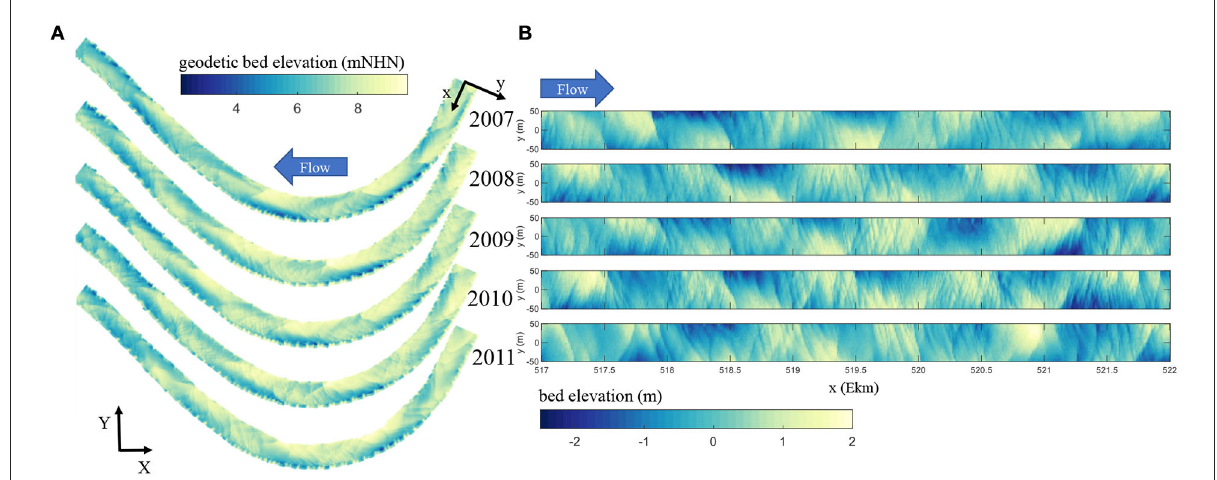
FIGURE5 Bed elevation data from 2007 to 2011 in AB2 (A) plotted in original geodetic coordinates and (B) cut and detrended bed elevation data plotted cross-section wise along the river centerline. Please note the different color scales.